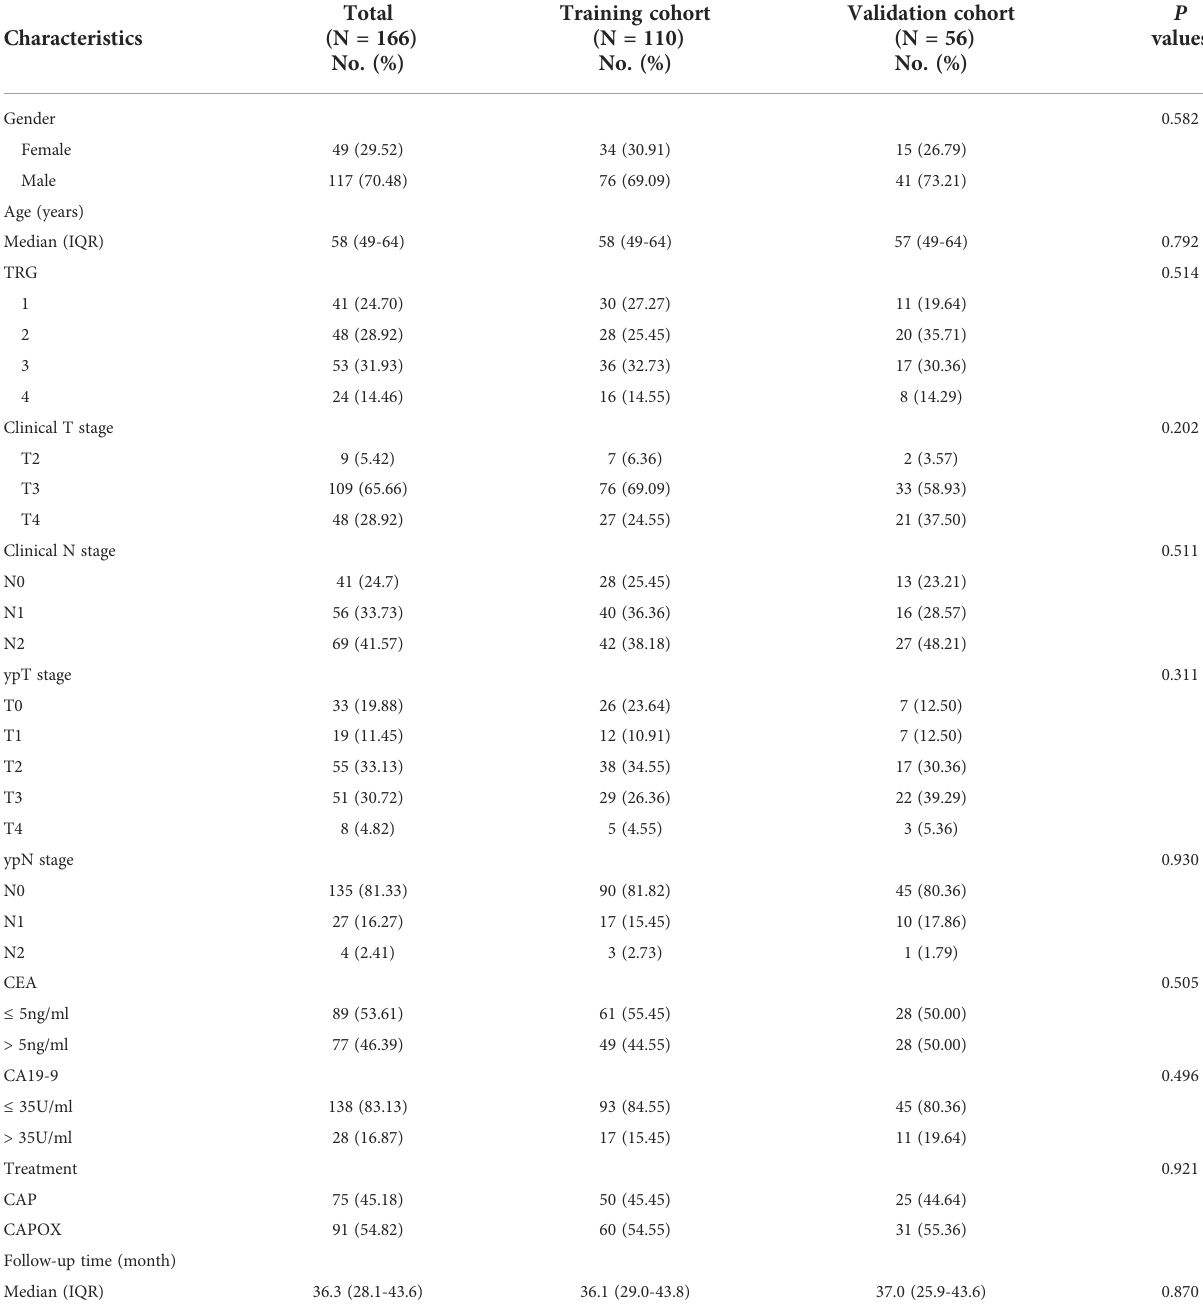
TABLE 1 Clinical and pathological characteristics of patients in the training and validation